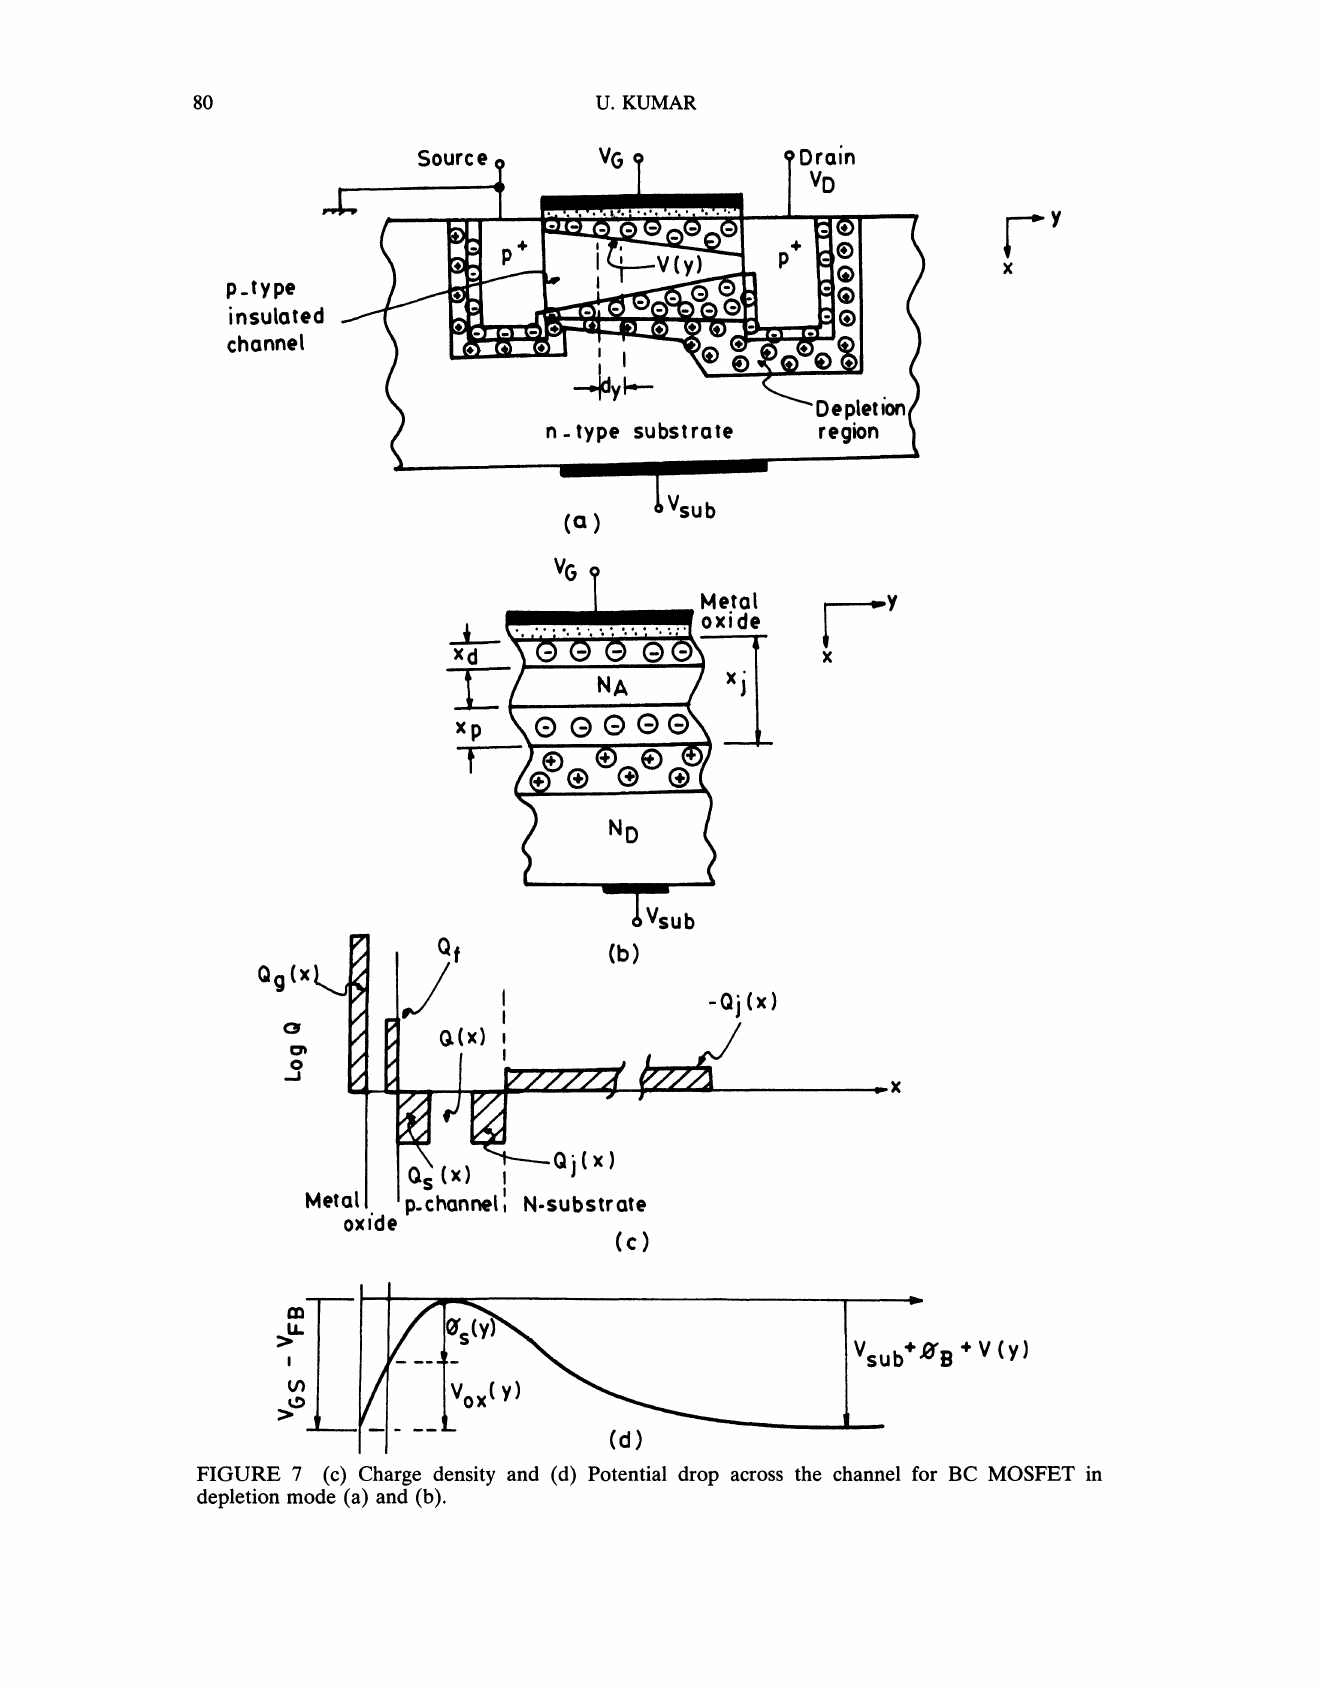
FIGURE 7 (c) Charge density and (d) Potential drop across the channel for BC MOSFET in depletion mode (a) and